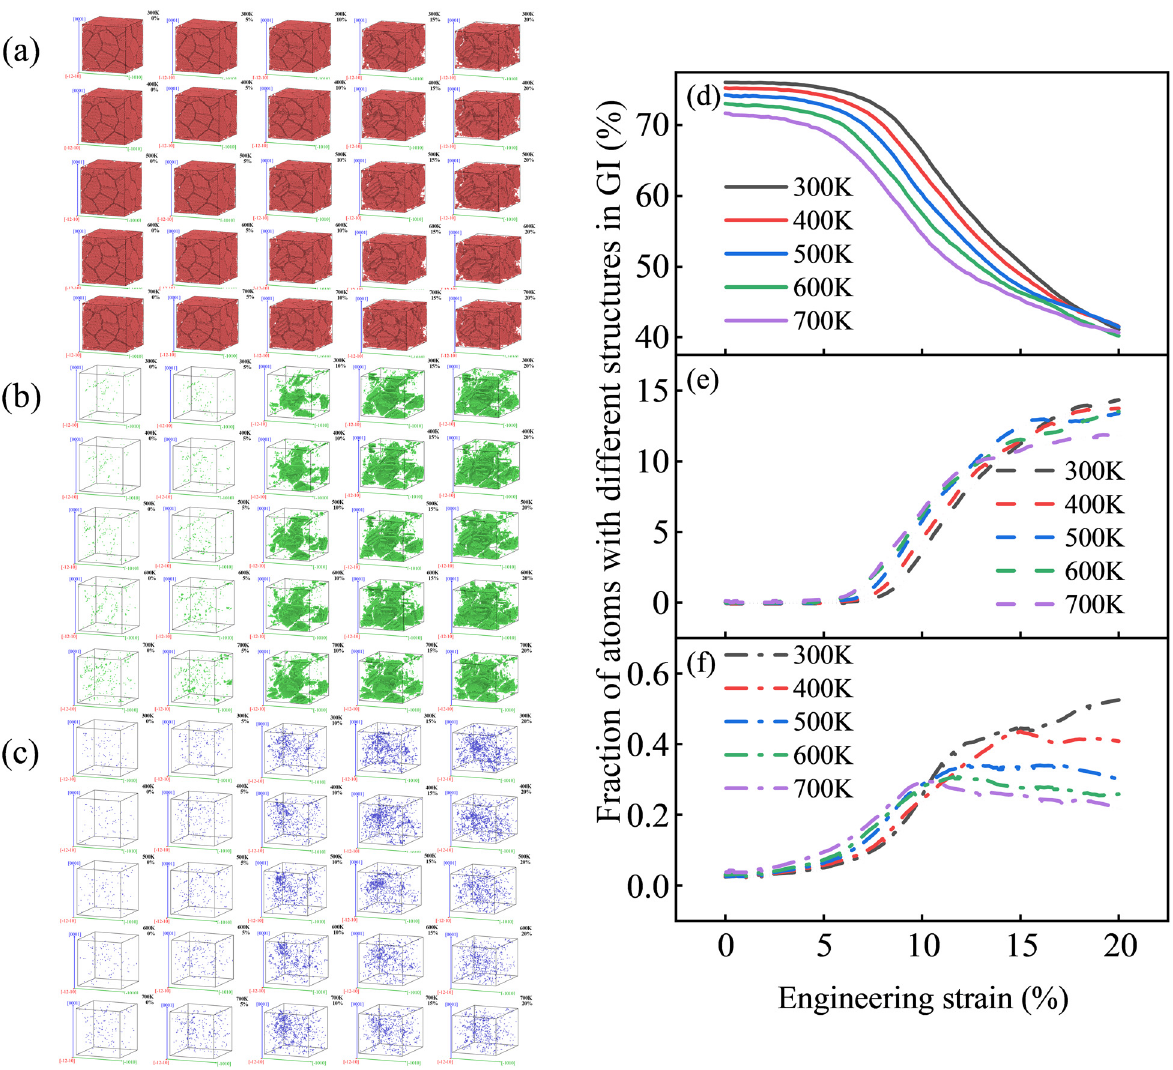
Figure 14: Structural evolution: ( a ) CNA diagram of HCP structure, ( b ) CNA diagram of FCC structure, ( c ) CNA diagram of BCC structure, ( d ) atomic curve of HCP structure, ( e ) atomic curve of FCC structure, and ( f ) atomic curve of BCC